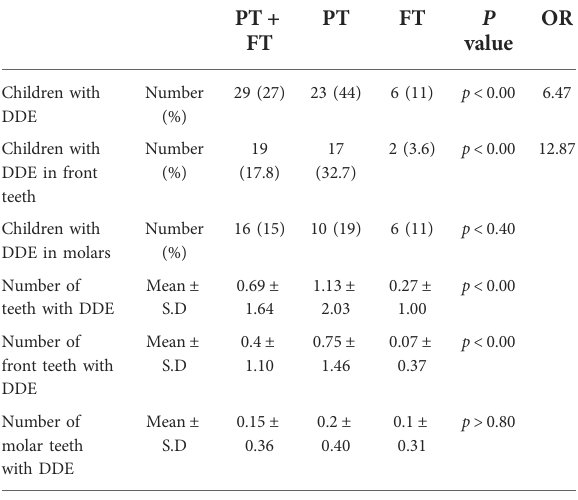
TABLE 3 The risk of developmental defect of enamel in incisor teeth according to various